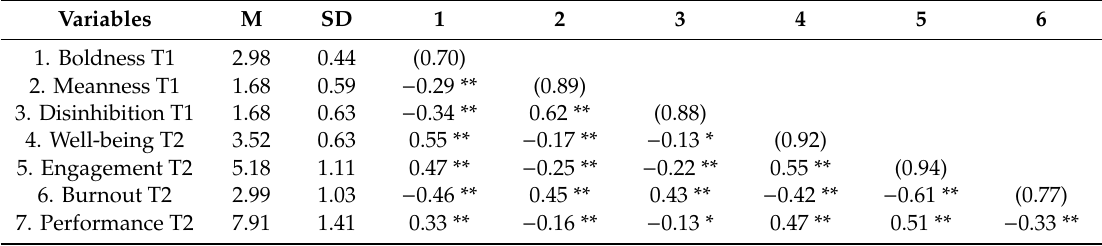
Table 4. Descriptive statistics for Sample 1 (managers, matched T1 and T2 data) ( N = 286). Variables